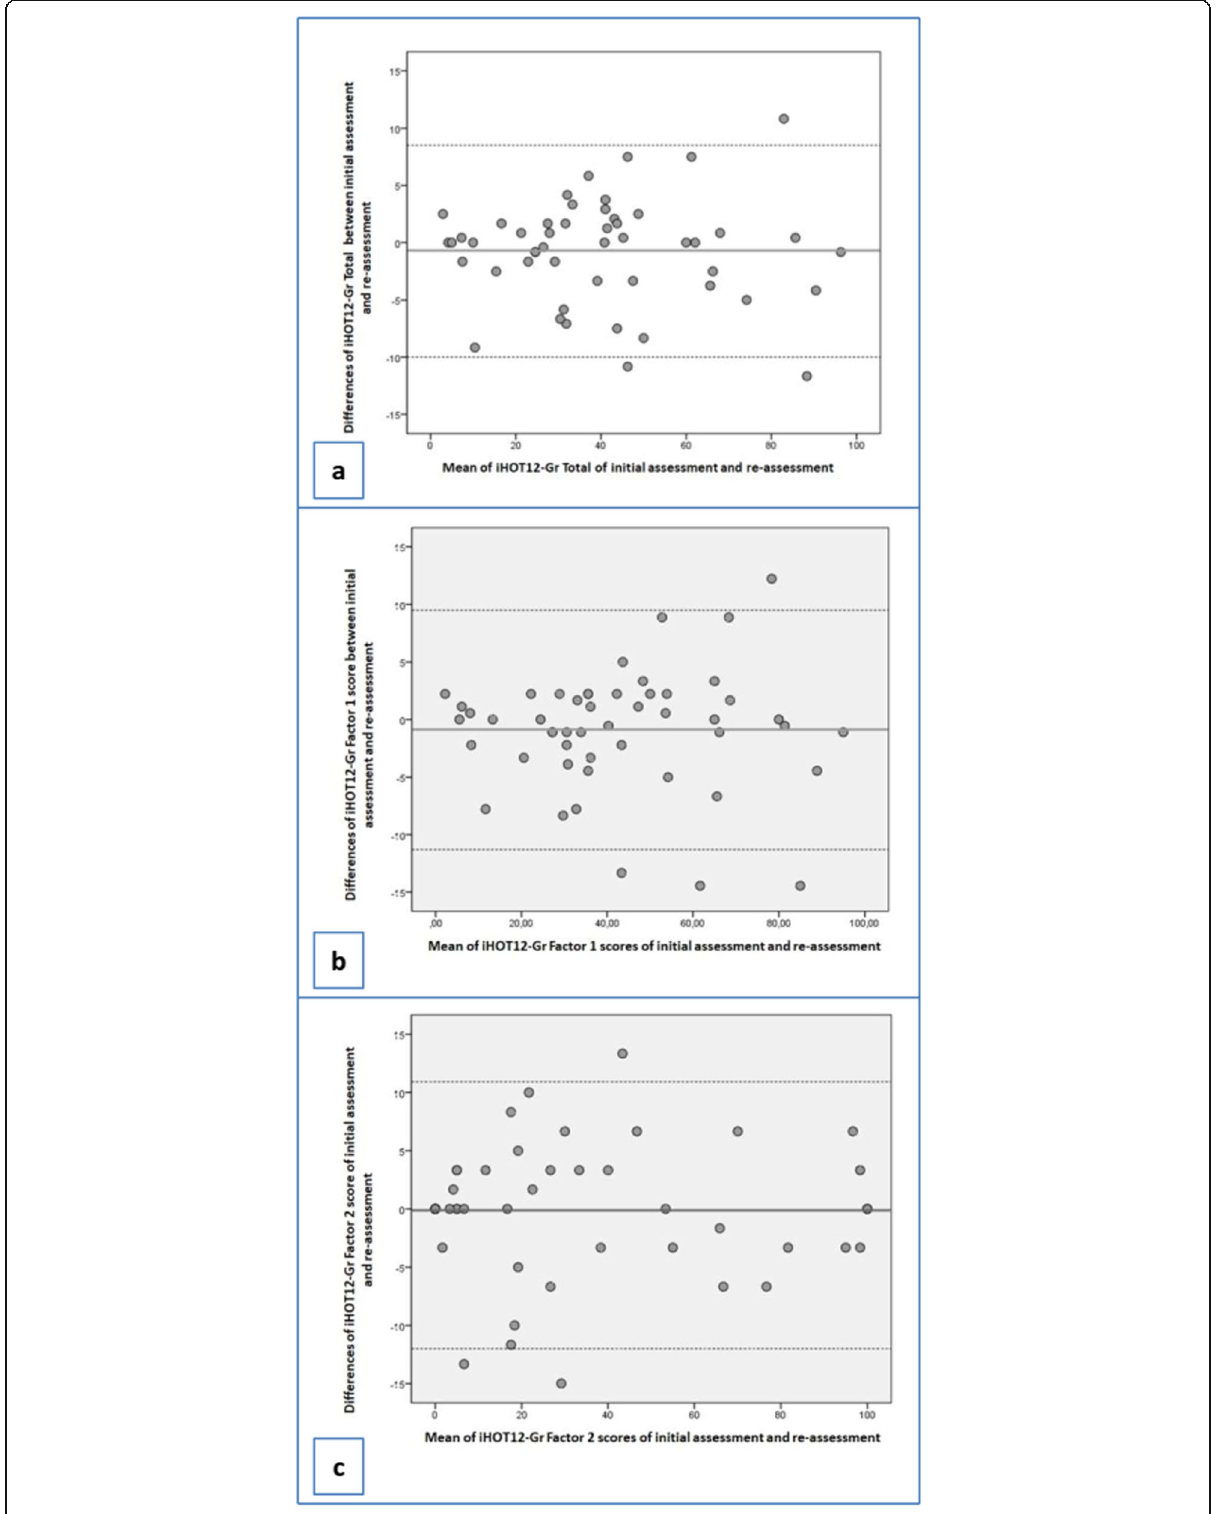
Fig. 4 Bland – Altman plots showing difference in means between initial assessment and reassessment of: a International Hip Outcome Tool – Greek version Total, b Factor-1, and c